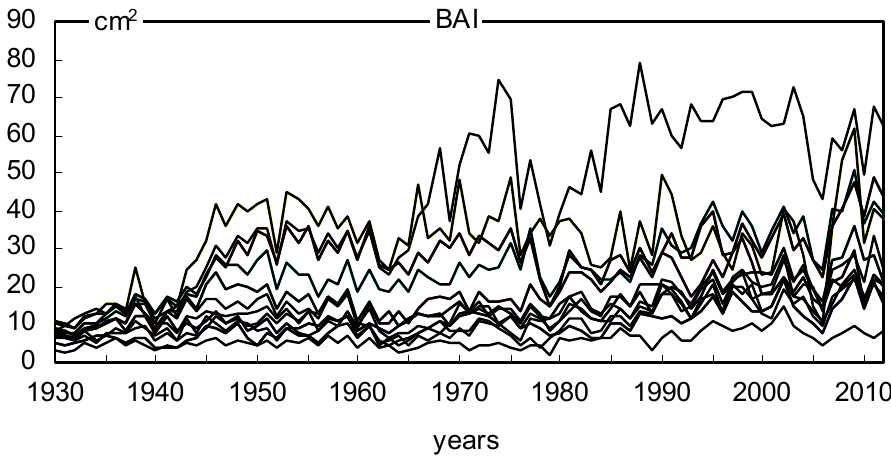
Figure 6. Eighteen site chronologies of basal area increment.